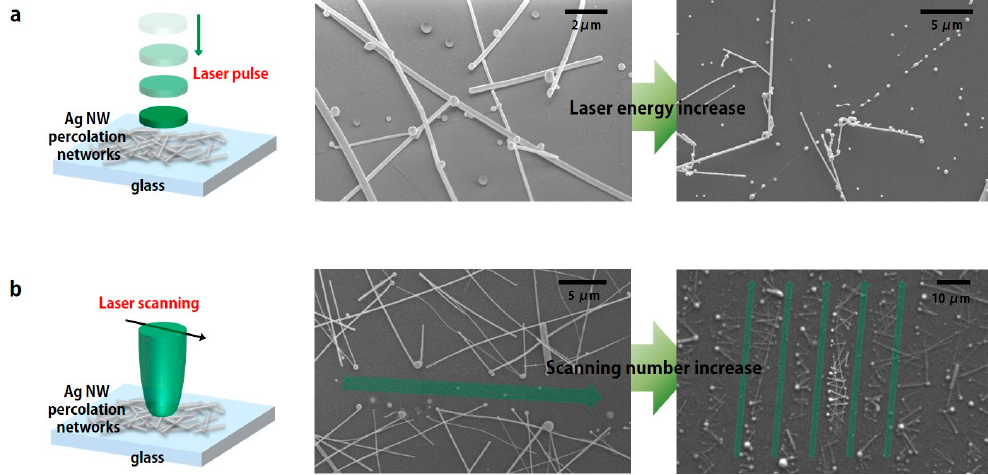
Figure 4. SEM images of Ag NW percolation networks when ( a ) the ns pulse LINW process and ( b ) the cw scanning LINW process are conducted under extremely high power/energy condition.